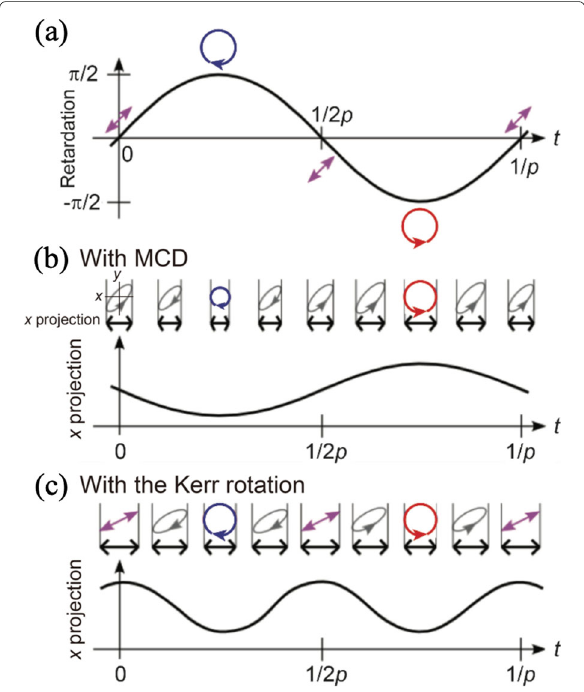
Fig. 24 Polarization switchings for the magneto-optical effects [32]. a Time dependence of the retardation δ = (π/ 2 ) sin2 π p K t , where p and t represent the modulation frequency and time, respectively. The polarization of light with retardation δ varies sequentially: skew linearly (SL) → right-handed circular → SL → left-handed circular → SL. b , c Schematic drawing that describes why the p K and 2 p K components represent MCD and the Kerr rotation,